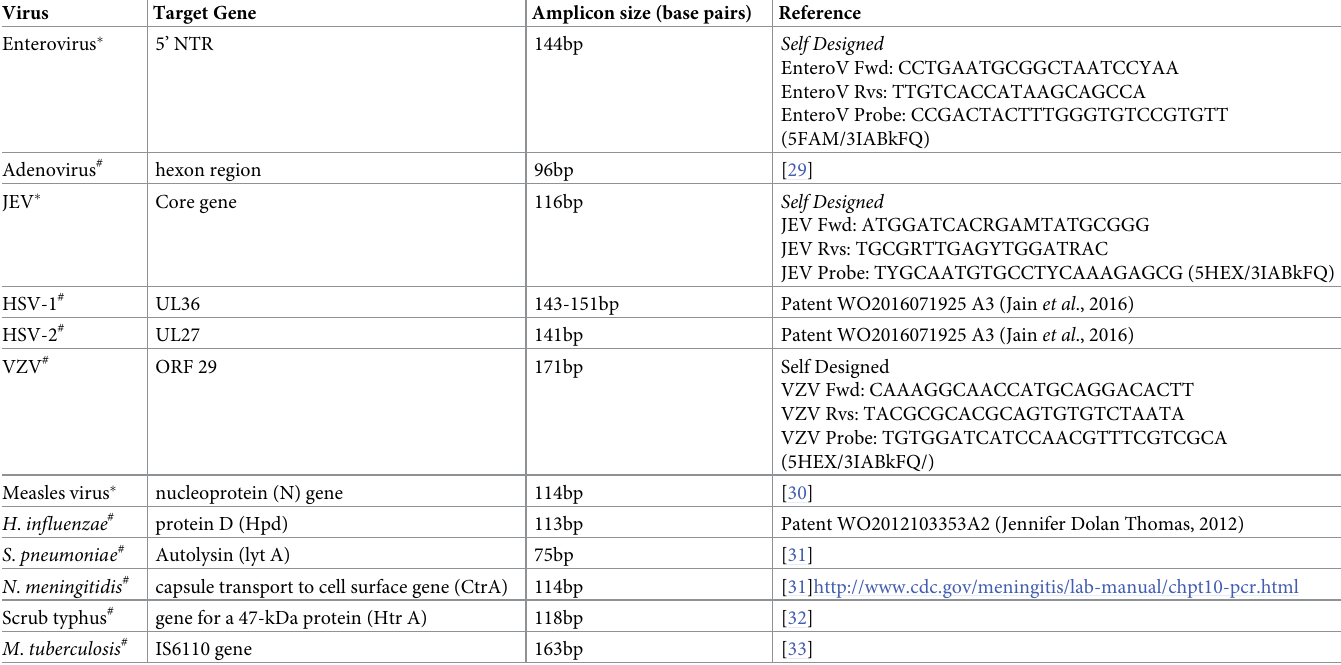
Table 1. Details of primers and probe used for real time